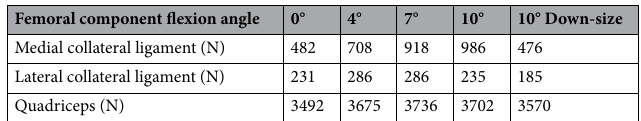
Table 4. Peak ligament force of each ligament and quadriceps in